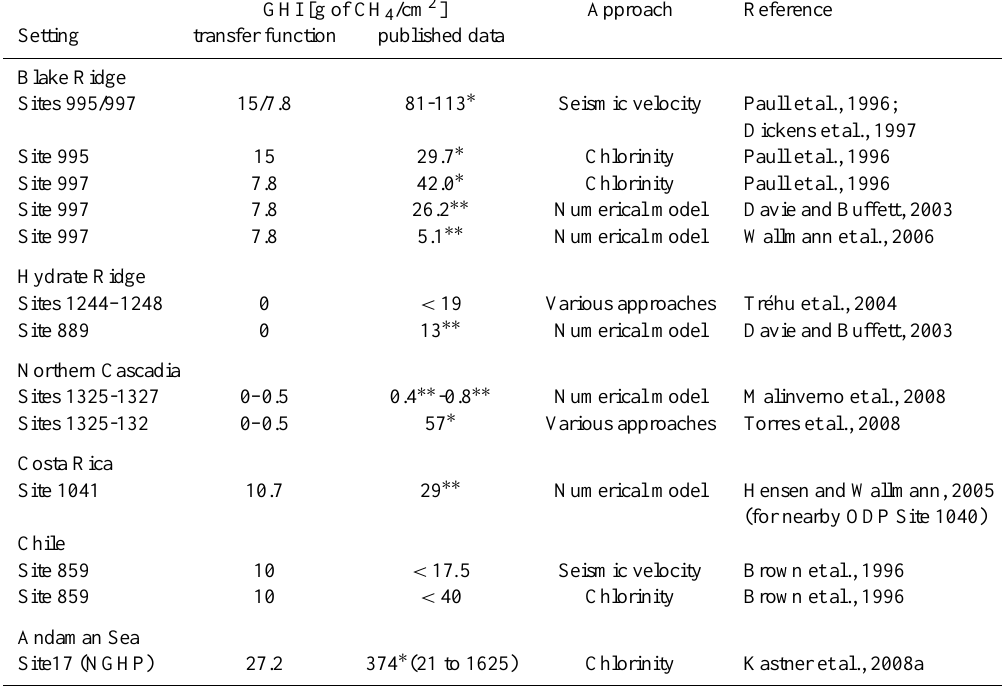
Table 4. Comparison of the GHI amount calculated with the transfer function to other published results (of average GH contents) obtained from several approaches, such as seismic velocity calculations, chlorinity, resistivity log or a combination of several of these methods. Other results obtained by numerical modelling are also shown. In order to use the transfer function (Eq. 6) at the sites which have been not modelled, POC values and sedimentation rates were taken from the ODP initial reports, or POCar was calculated using Eq. (3). The GHSZ was deduced from BSR depths given in the respective ODP initial reports. Published gas hydrate concentrations have been converted from vol.% of pore space to g of CH 4 /cm 2 (considering a mean porosity of 0.5 and the thickness of the gas hydrate-enriched sediment at each site) representing the depth integrated mass of GH per unit area of